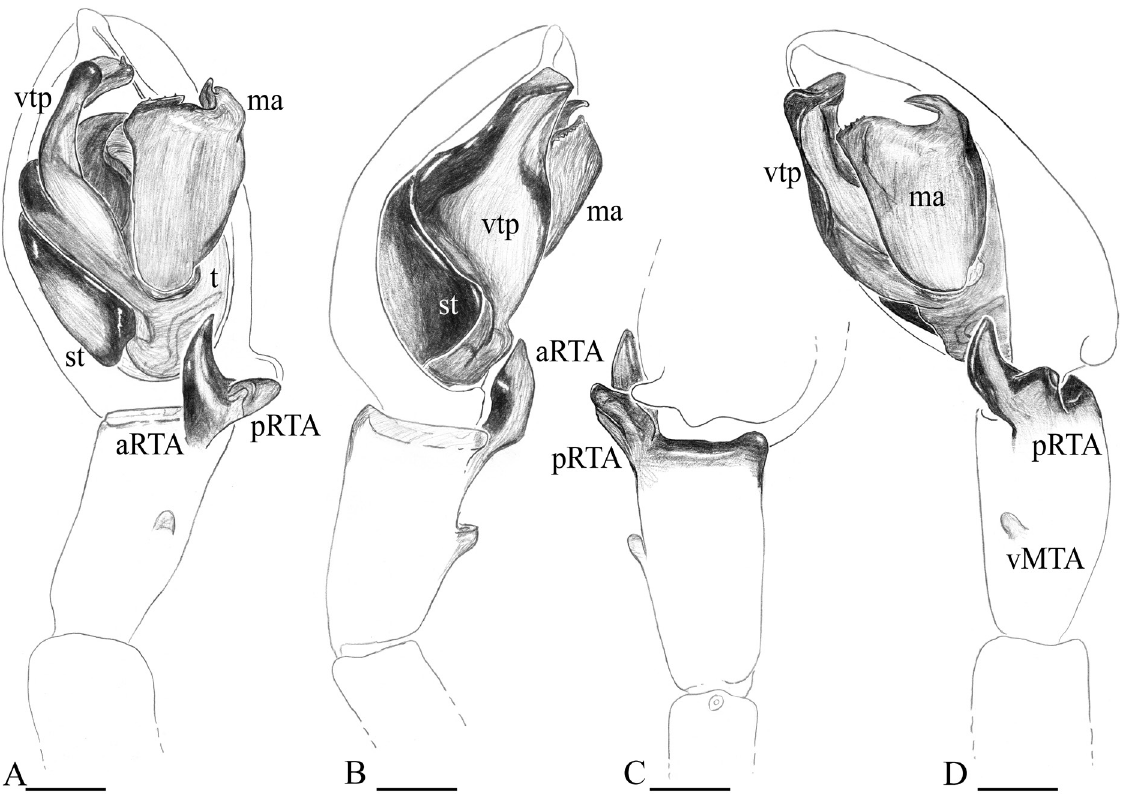
Fig. 49. Anyphaena megamedia sp. nov., paratype, ♂ (CNAN-T01558). A . Pedipalp, ventral view. B . Pedipalp, prolateral view. C . Pedipalp, dorsal view. D . Pedipalp, retrolateral view. Scale bars: 0.2